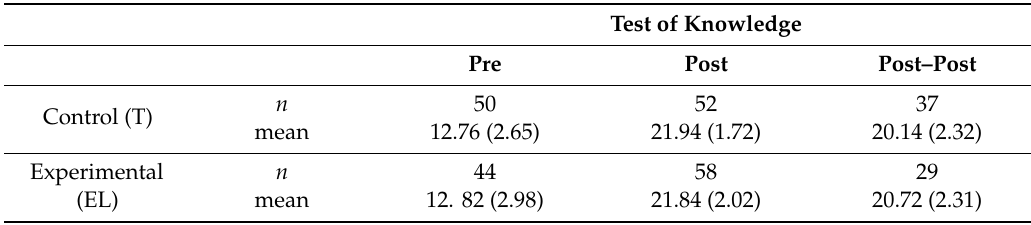
Table 7. Knowledge test results: pre, post, and